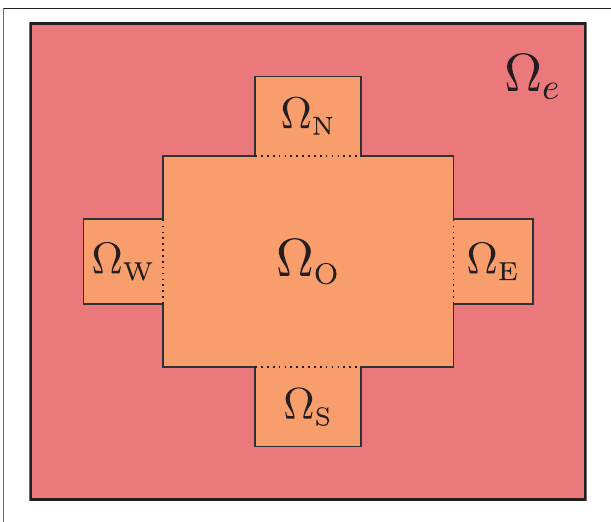
FIGURE 8 | Two-dimensionalillustration ofthe geometry used for a single cellinthesimulationsofcollectionsofconnectedcells.Theintracellulardomainis a composition of the subdomains Ω O , Ω W , Ω E , Ω S , and Ω N , and all these subdomains are shaped as rectangular cuboids with sizes speci fi ed in Table 3 . The fi gure is reused from Ref. 48 with permission from the publisher.